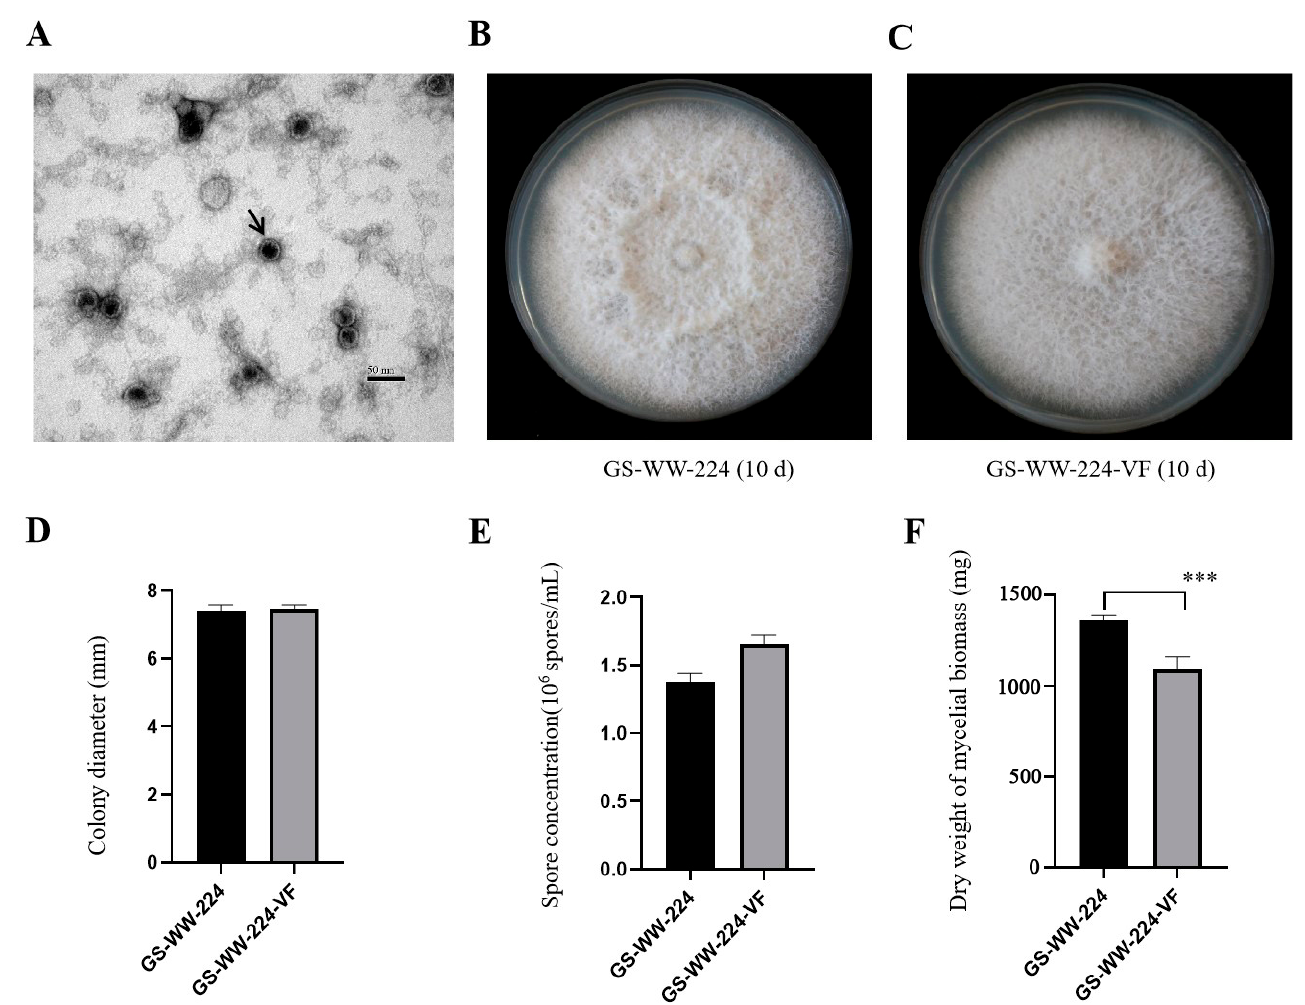
Figure 3. Virions of Fusarium avenaceum alternavirus 1 (FaAV1) and colony morphology, colony diameter, spore concentration, and dry weight of mycelial biomass of Fusarium avenaceum strains GS-WW-224 and GS-WW-224-VF. ( A ) Transmission electron microscope (TEM) image of virions of FaAV1 indicated by a black arrow. Scale bar = 50 nm. ( B ) Colony morphology of strain GS-WW-224 cultured on potato dextrose agar (PDA) plates for ten days at 25 °C in the dark. ( C ) Colony morphology of strain GS-WW-224-VF cultured on PDA plates for ten days at 25 °C in the dark. ( D ) Average colony diameter of strains GS-WW-224 and GS-WW-224-VF incubated on PDA plates for seven days at 25 °C in the dark. ( E ) Average spore production in strains GS-WW-224 and GS-WW-224-VF cultured on PDA plates for seven days at 25 °C in the dark. ( F ) Average dry weight of mycelial biomass generated in strains GS-WW-224 and GS-WW-224-VF cultured in potato dextrose broth (PDB) for seven days at 25 °C in the dark. Asterisks indicate different levels of significant difference (*** p < 0.001) between the two strains as determined by paired t-test using GraphPad Prism version 8.0 software.